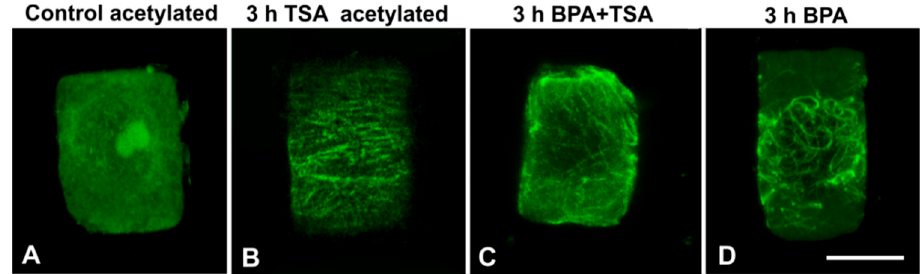
Figure 10. Maximum projections of CLSM sections, after acetylated α -tubulin ( A, B ) or total α -tubulin ( C, D ) immunolocalization in control and variously-treated (as noted) A. cepa interphase root cells. Scale bar: 10 μ m.